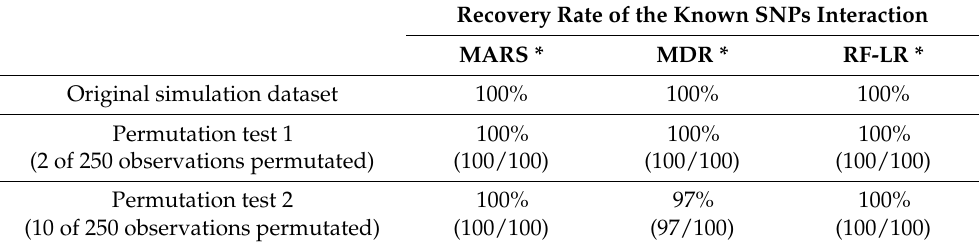
Table 1. Recovery rate of the known SNP4–SNP9 interaction by using three machine learning approaches in the original simulation dataset and permutation